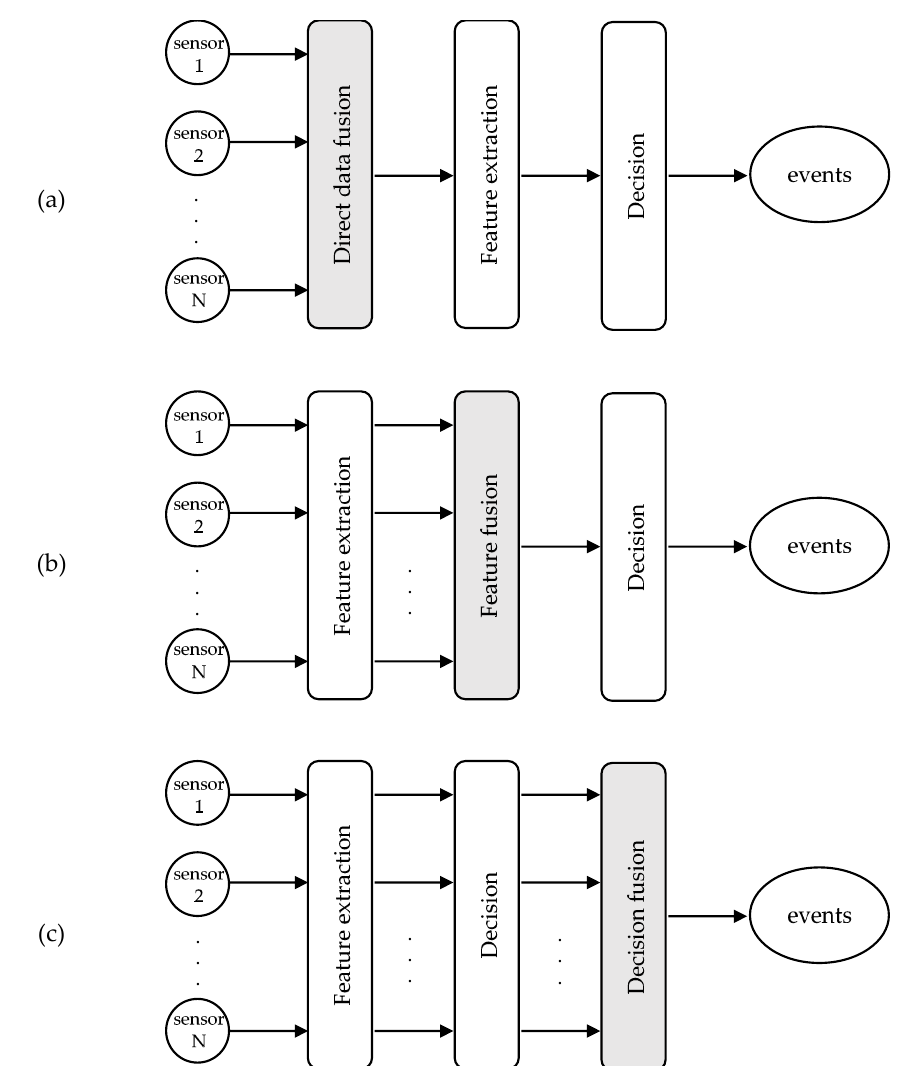
Figure 1. Schematic diagrams showing fusion architectures at data ( a ), feature ( b ), and decision ( c ) levels.